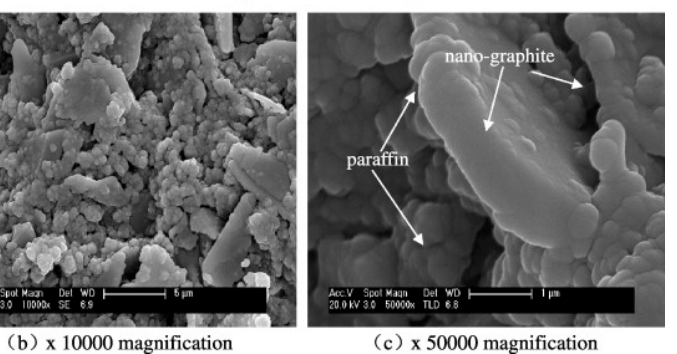
Figure 6. SEM images of palmitic acid/CNT NEPCM: ( A ) pristine CNTs, ( B ) treated CNTs, and ( C ) palmitic acid containing treated CNTs. (Reprinted with permission from ref. [23]. Copyright 2010 Solar Energy). 4. Results of Previous Studies Previous investigations are described and summarized in Table 1 and discussed in more detail in Section 3.1 of this review for the more common NEPCMs shown, including the compounds, how they are characterized and what preparation techniques are used to form the NEPCMs. Table 2 below encompasses selected studies summarized in Table 1 and compares the thermal conductivity, latent heat, and phase change temperature be- tween the basic PCM and their NEPCM counterpart.